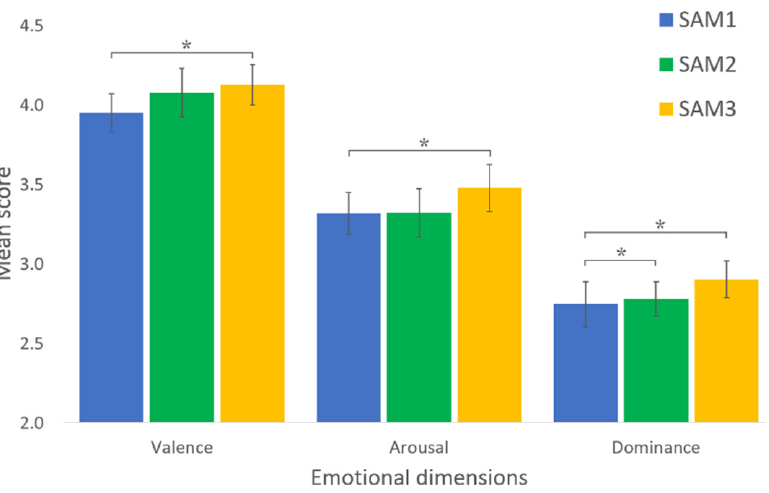
Figure 10. Score comparison between SAM1, SAM2 and SAM3 tests of the three emotional dimen- sions. * denotes significance at the (<0.05) level.